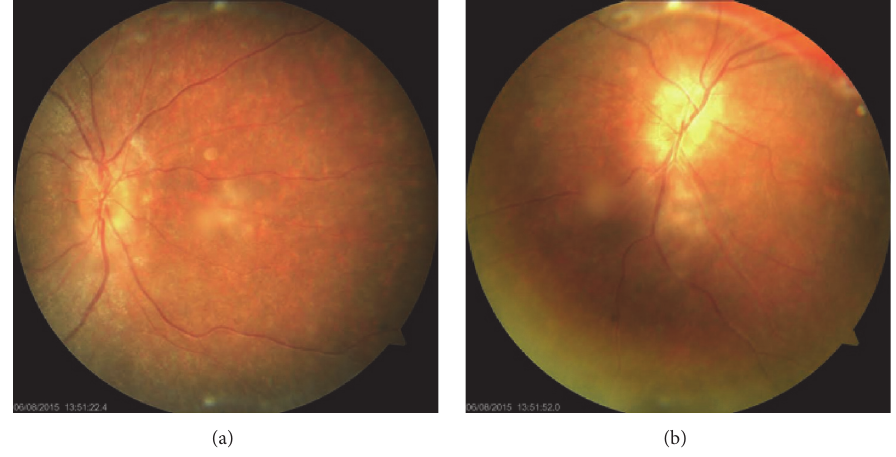
Figure 1: Appearance of pale optic disk and irregular optic disc margins.